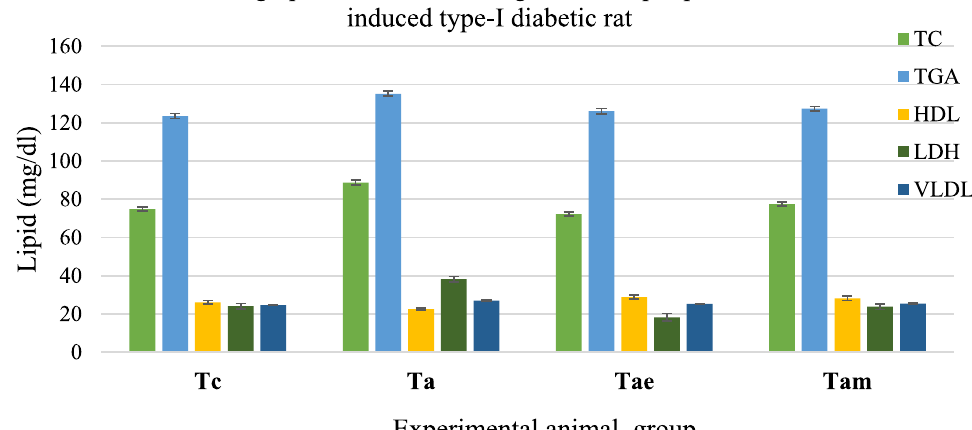
Fig. 4 Effect of mango peel extract and mangiferin on serum lipid profile in the alloxan-induced type I diabetic rat. The fluctuations of serum cholesterol, triglyceride, HDL, LDL, and VLDL levels in different groups are stated in this figure. Ta group has higher serum cholesterol, triglyceride, HDL, LDL, and VLDL levels than the Tc. Tae and Tam groups have lower cholesterol levels compared to the diabetic group (Tc)